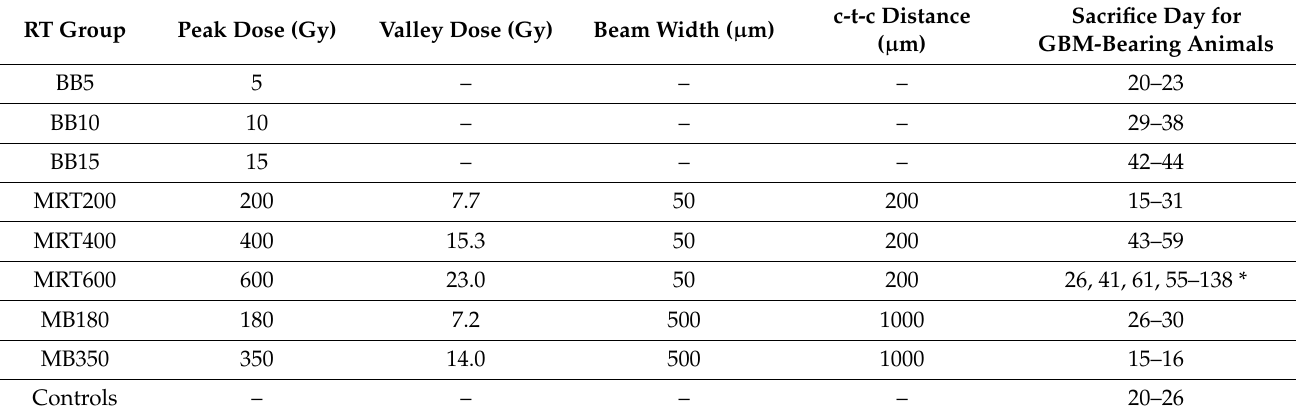
Table 1. Irradiation parameters for healthy and GBM-bearing animals. The sacrifice day column is referred to the GBM- bearing groups. The sacrifice day for healthy animals was set to D138. * D26, 41 and 61 where fixed as sacrifice points to study the tumor and microcalcifications evolution.